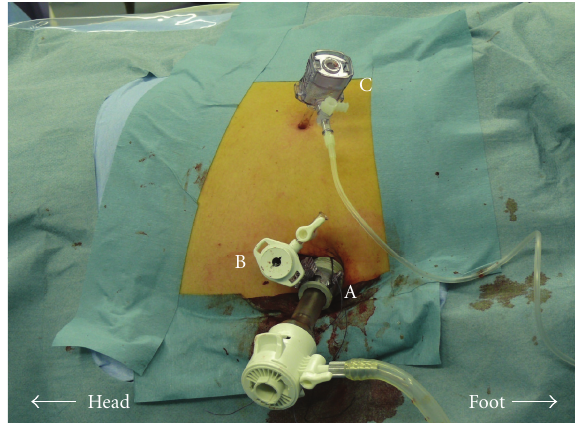
Figure 2: Trocar placement for left adrenalectomy with the LESS combined technique. The primary 12-mm trocar (A) and a 5-mm nonbladed trocar (B) were located next to one another through a 2.5-cm skin incision. A 3-mm nonbladed trocar (C) was added along the anterior axillary line.